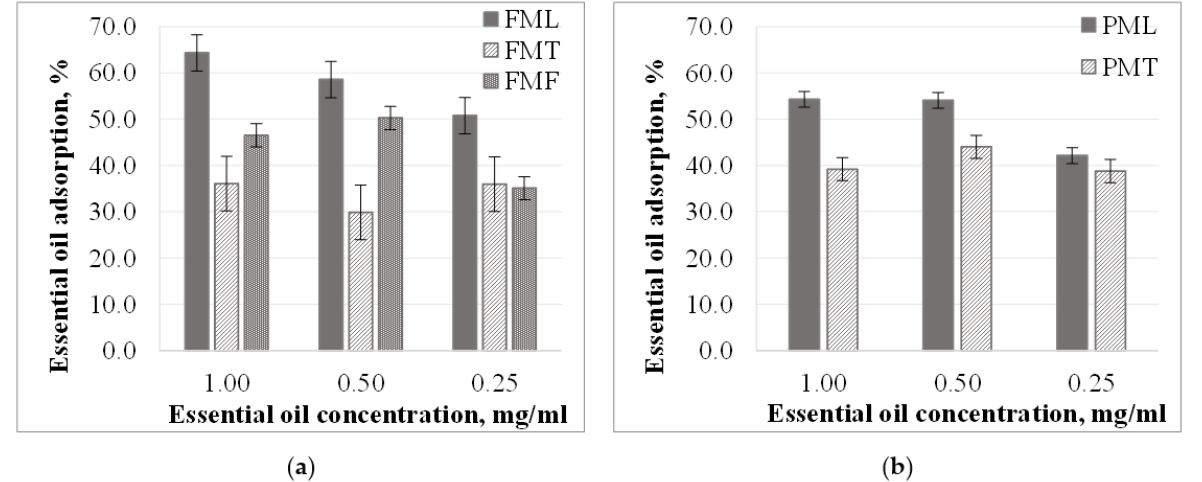
Figure 5. Essential oil adsorption (%) in methanol solutions in the case of ( a ) particles from F granules; ( b ) particles from P granules.